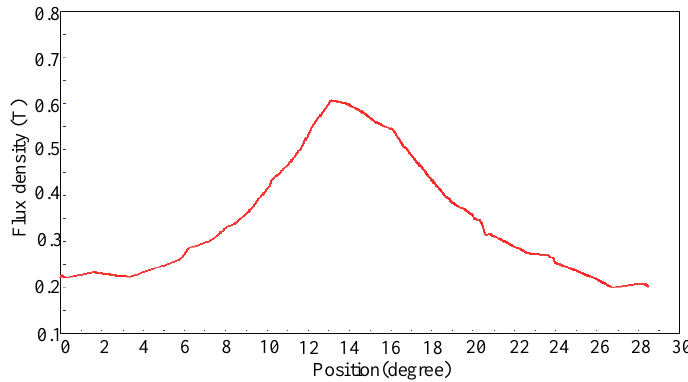
Figure 6. Magnetic flux density of the air gap.